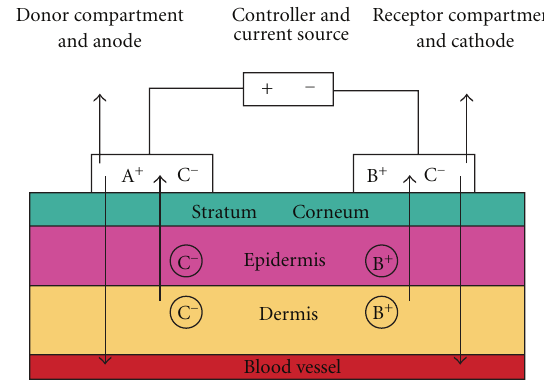
Figure 8: Iontophoresis. Components of an anodal iontophoretic device are a current source; a current control device; anode (donor) reservoir system (with a positively charged drug/ion in solution); cathode reservoir system (on a di ff erent skin site). With an electric current, all cations move away from the anode and into the skin, and negatively charged ions move from the body into donor